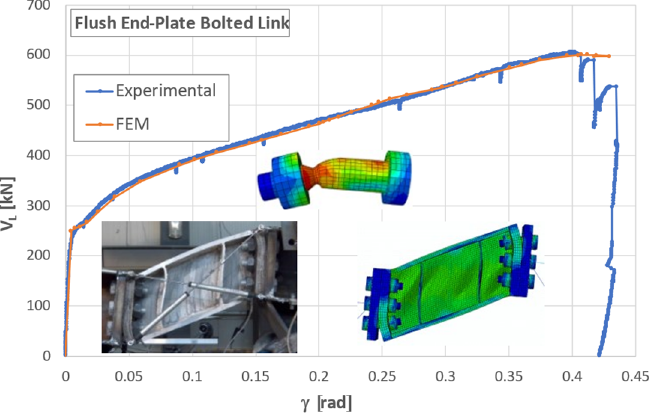
Figure 11. Comparison between experimental and FEM monotonic test of a flush end plate bolted link.